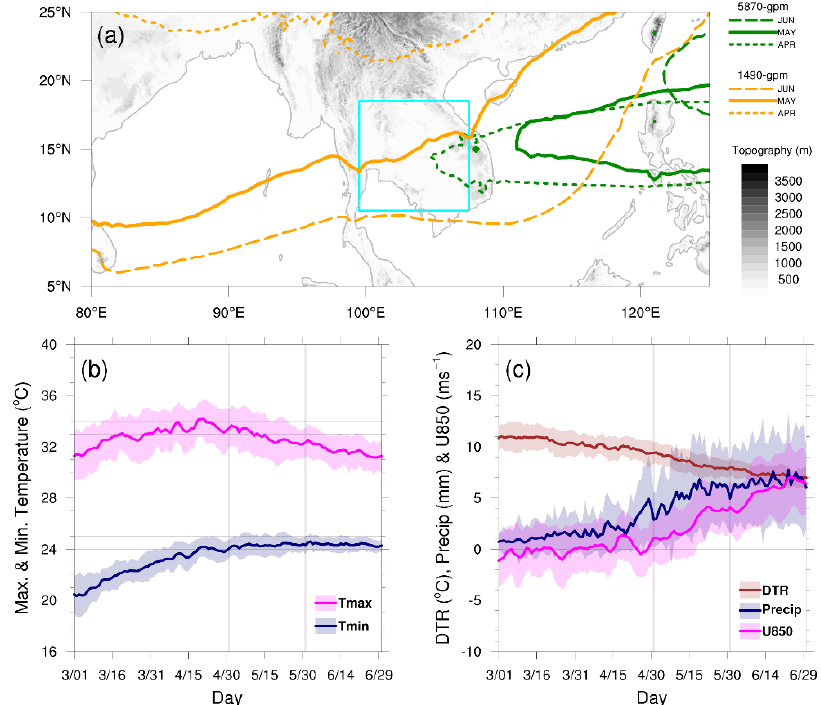
Figure 1. ( a ) The climatological 5870-gpm (green) and 1490-gpm (orange) contours derived from the 500 and 850 hPa geopotential height fields, respectively, for April, May, and June. The topography is shown in meters. The cyan box denotes the ICP region used in this study. The climatological time series of the area-averaged ( b ) daily maximum and minimum surface air temperatures (Tmax and Tmin) and ( c ) diurnal temperature range (DTR), precipitation (Precip), and zonal wind component at 850 hPa (U850) over the ICP region. The solid lines represent the means of daily climatology, while the shaded envelopes enclose the interannual spreads denoted by their respective ± one standard deviation from the mean. The monthly (daily) climatology is computed as a time mean for each calendar month (day) during the period 1979 to 2021. The daily standard deviation is estimated for each calendar day from this 43-year period. The horizontal gray lines in panel ( b ) indicate 24, 25, 33, and 34 °C. The vertical gray lines indicate 1 May and 31 May, respectively.